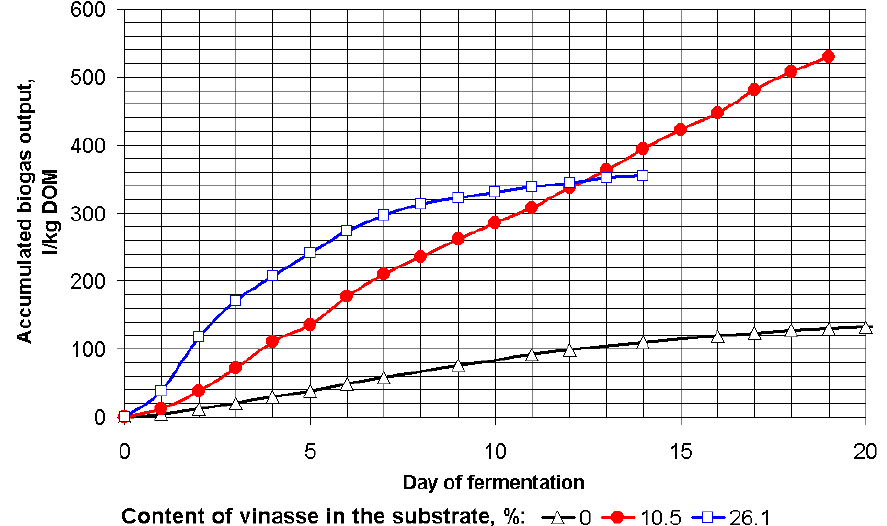
Figure 5. Accumulated biogas output from the joint digestion of cattle manure and molasses at a fermentation temperature of 40 ◦